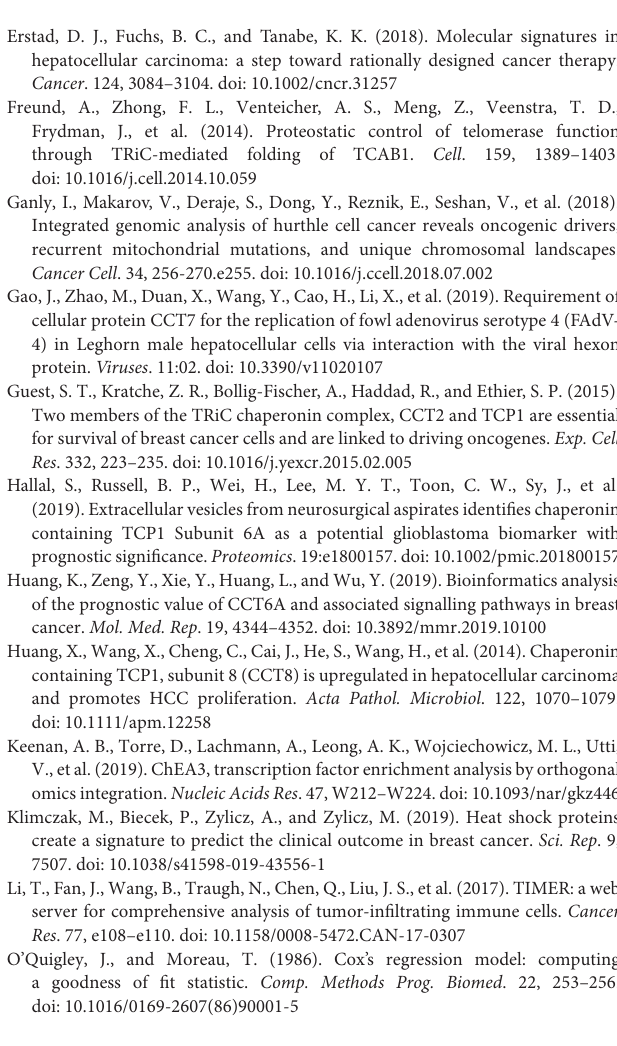
Supplementary Figure 1 | Multivariate analysis of CCT subunit genes and clinical characteristics in the TCGA cohort.